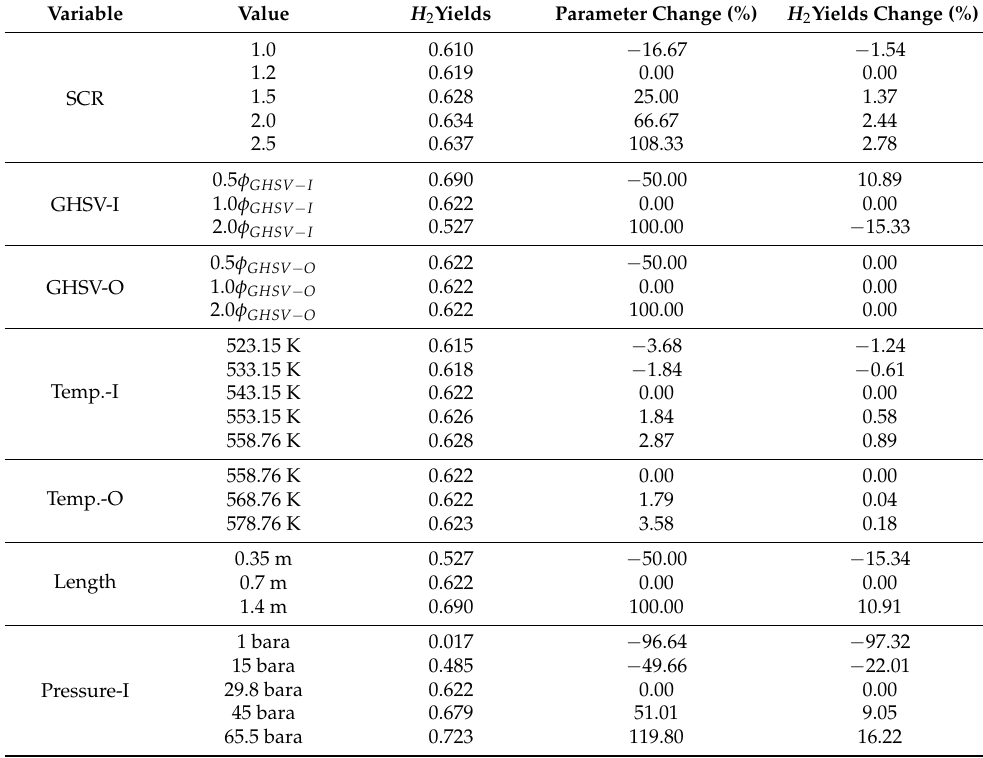
Table 4. Hydrogen mole fraction for various parameter